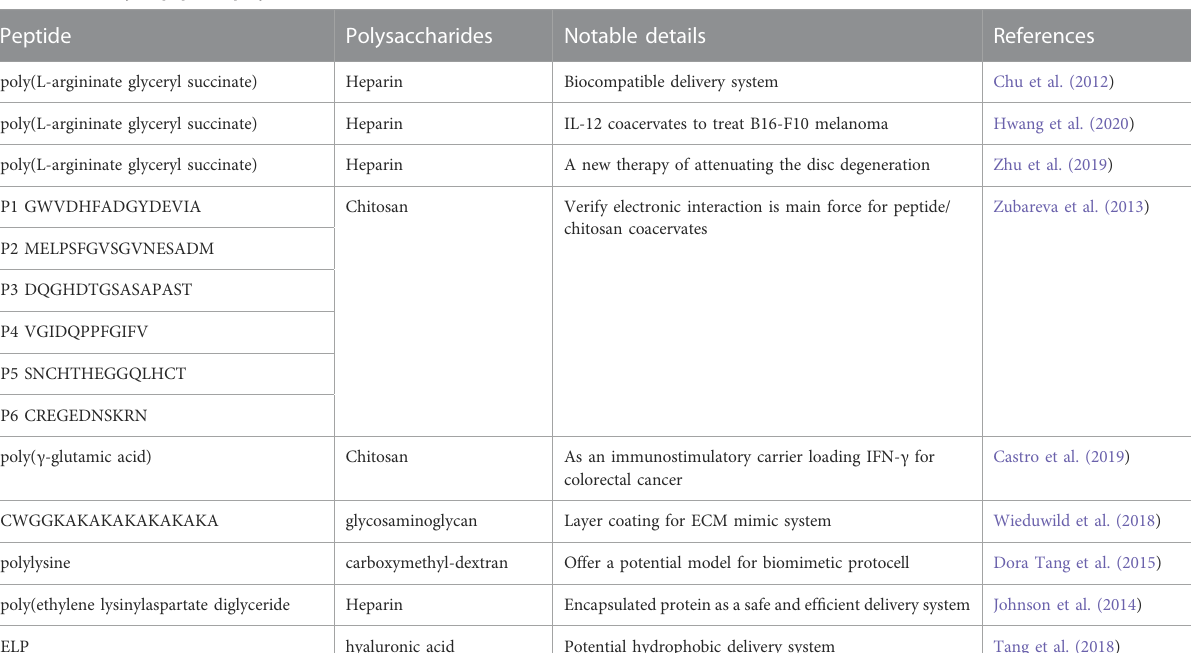
TABLE 5 Summary of peptide- polysaccharides